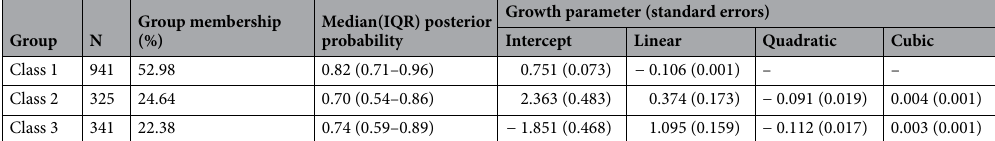
Table 3. Trajectory descriptions, median posterior probabilities and growth parameter among girls, CFPS. Three trajectories identified through latent class trajectory modeling with the TRAJ procedure using the censored normal model. The polynomials in age of Class 1 included linear; the polynomials in age of Class 2 included linear, quadratic and cubic; and the polynomials in age of Class 3 included linear, quadratic and